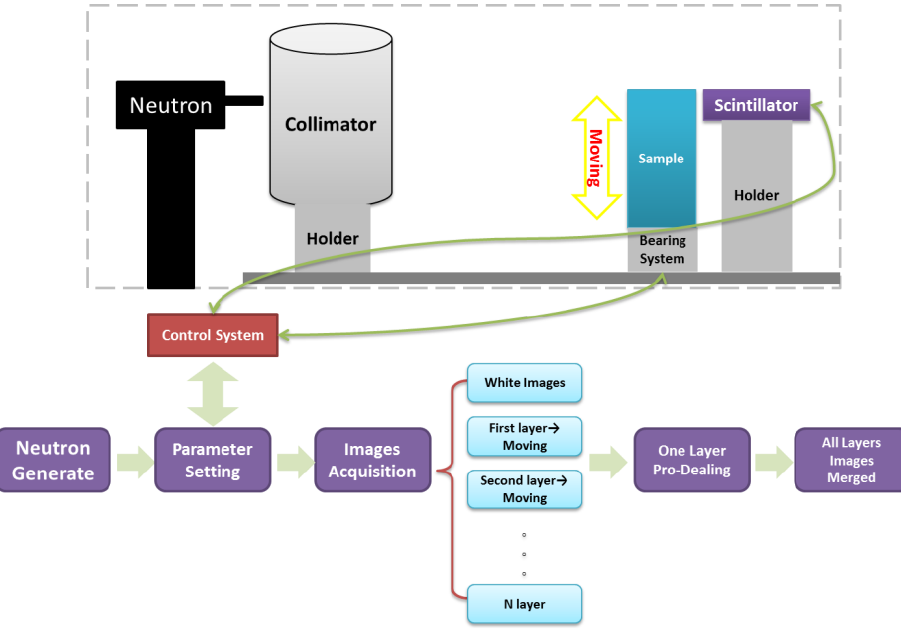
Figure 10. Experimental process of scanning imaging.